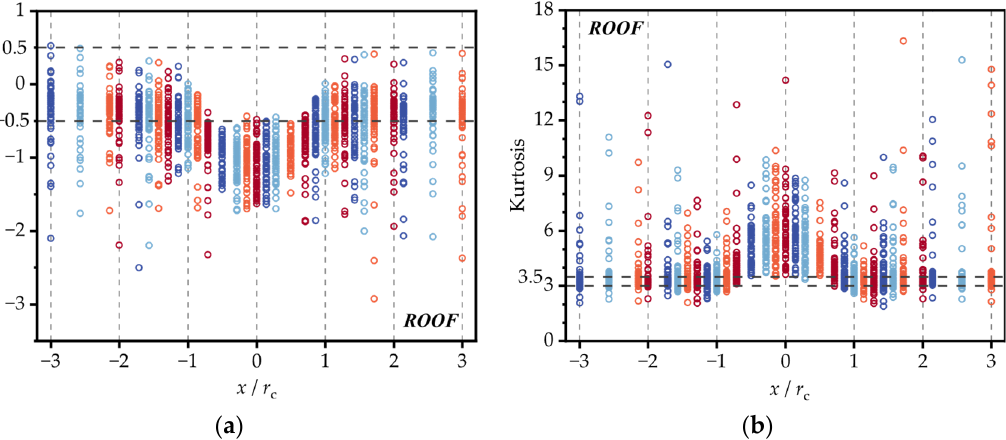
Figure 7. Skewness and kurtosis at roof taps. ( a ) Skewness at roof taps and ( b ) kurtosis at roof taps.